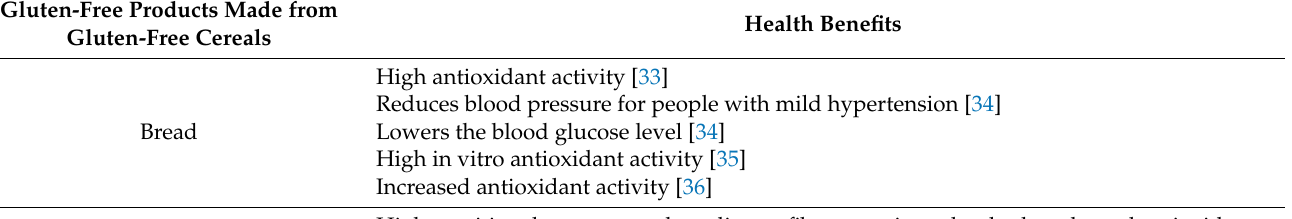
Table 2. Health benefits of gluten-free products made from gluten-free